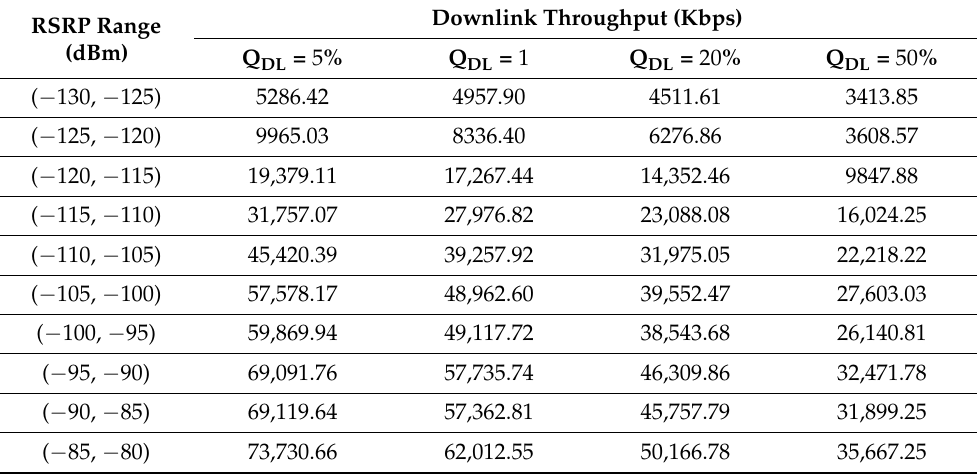
Table 3. The relationship between downlink throughput and